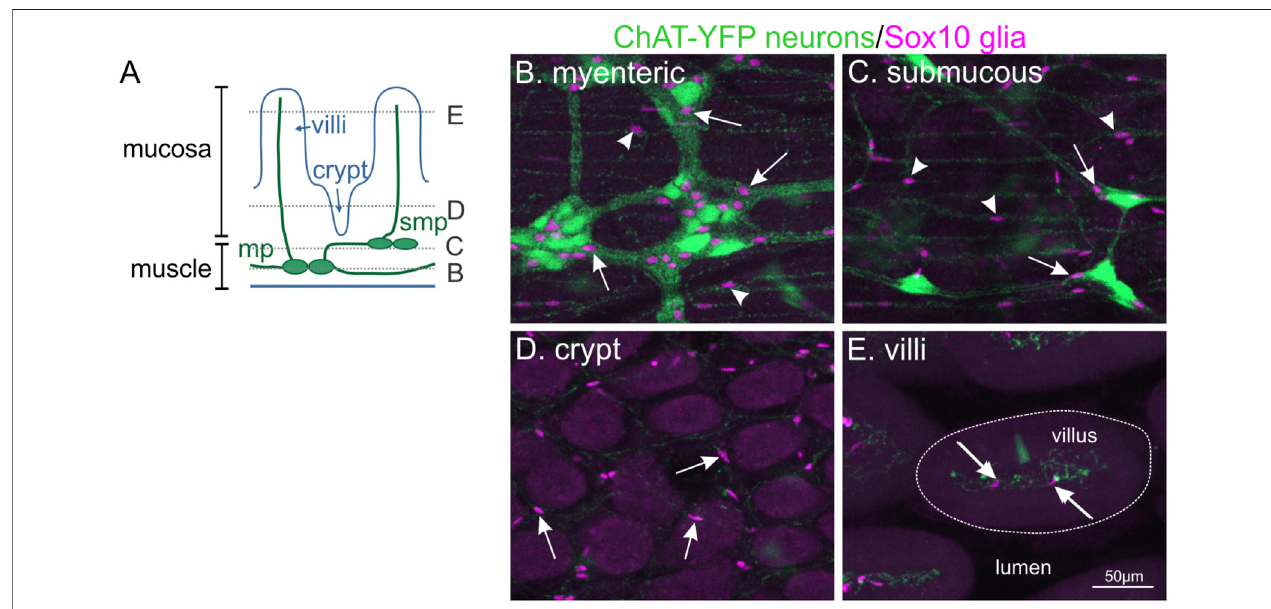
FIGURE 1 | Enteric glial cells are located throughout all different concentric layers of the gut. (A) : Diagram of the different cell layers in the small intestine. (B – E) : Whole-mount immunohistochemistry on the small intestine of ChAT-YFP mouse, where excitatory enteric neurons are labelled with GFP. Ce3D clearing was performed to visualise all tissue layers. The location of Sox10-immunoreactive enteric glial nuclei (magenta, arrows) can be observed with neuronal cell bodies in the myenteric plexus(mp,B),submucousplexus(smp,C)andalsoassociatedwithneuronal fi bresinthemusclelayers(arrowheads).Inaddition,entericgliaarefoundthroughout the mucosa surrounding the crypts (D) and in villi (E).